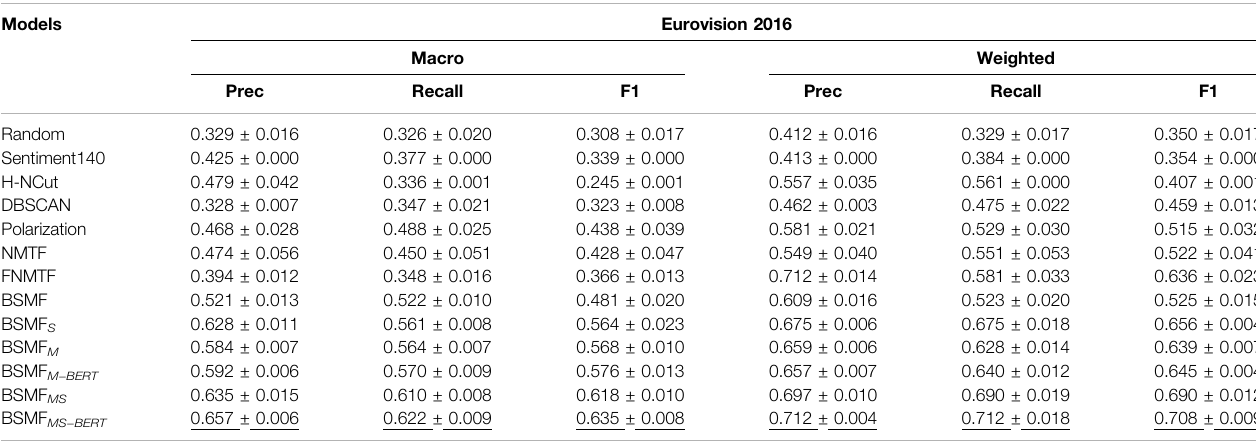
TABLE 4 | Macro- and weighted- metrics comparison (eurovision 2016).